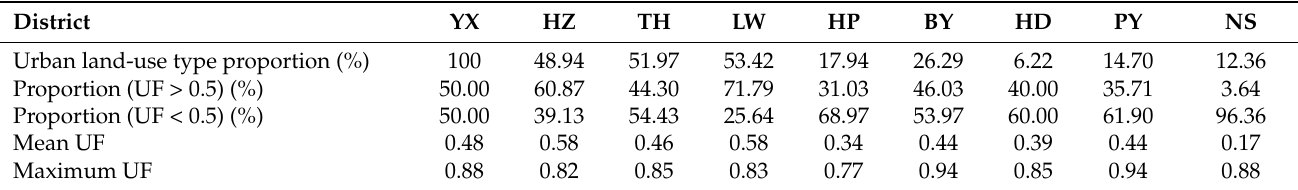
Table 1. Statistical details about the urban fraction (UF) in different districts.